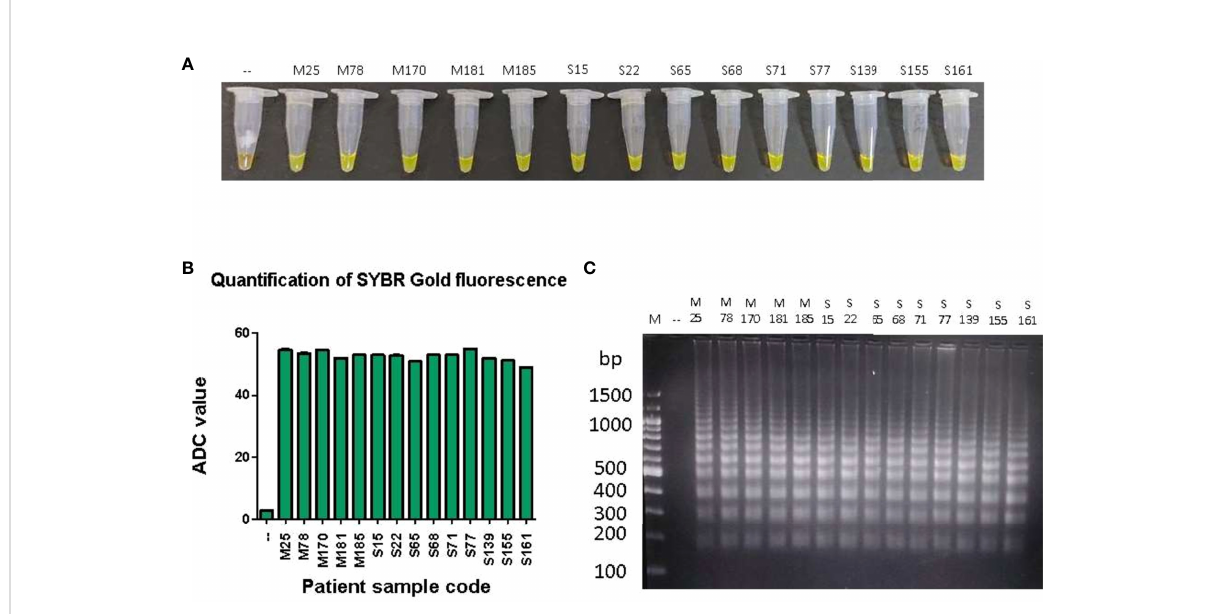
FIGURE 4 LAMP ampli fi cation of P. falciparum DNA from patient samples.One hundred pg of DNA from 90 patient samples were used in a LAMP reaction for 100 minutes, as described in Materials and Methods. (A) The con fi rmation of LAMP ampli fi cation was done by SYBR Gold detection. Diluted SYBR Gold nucleic acid stain was added to the LAMP products, and the color change was detected by visual examination. – : non-template control. (B) The quanti fi cation of SYBR Gold fl uorescence was done by measuring the fl uorescence intensity of the samples by a detection device, designated as ADC values. The mean + SEM of 10 ADC values are plotted for each sample. (C) Electrophoresis of LAMP products on a 2.5% agarose gel. M: 100 bp DNA ladder.